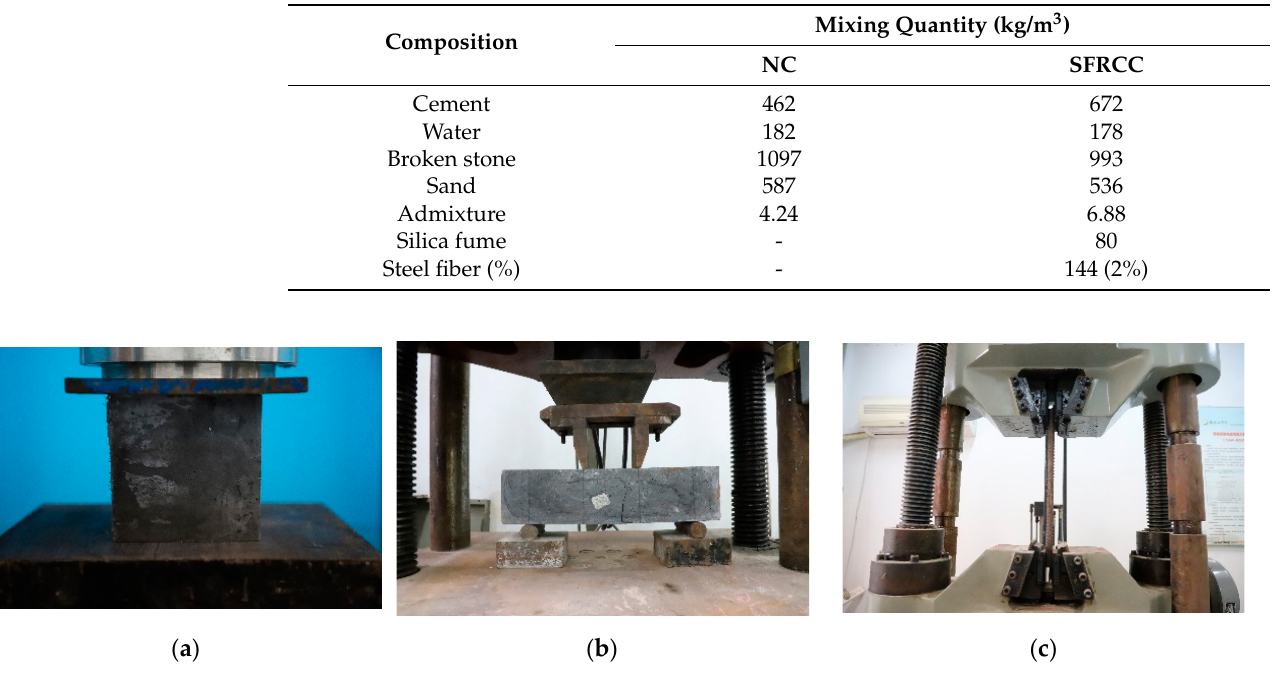
Figure 3. Measurement of mechanical properties: ( a ) concrete compression test; ( b ) concrete bending test; and ( c ) rebar tensile test. Table 2. Mechanical Properties of Materials.